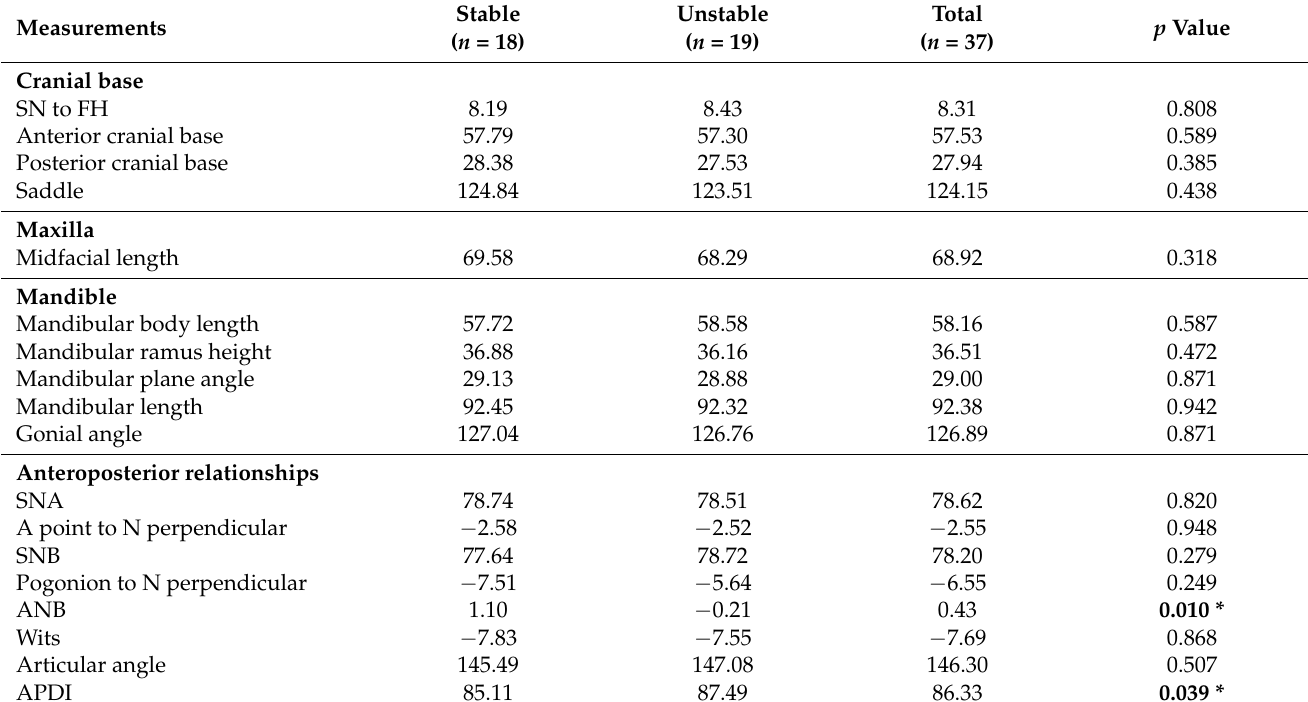
Table 4. Comparison of the two study groups in the initial